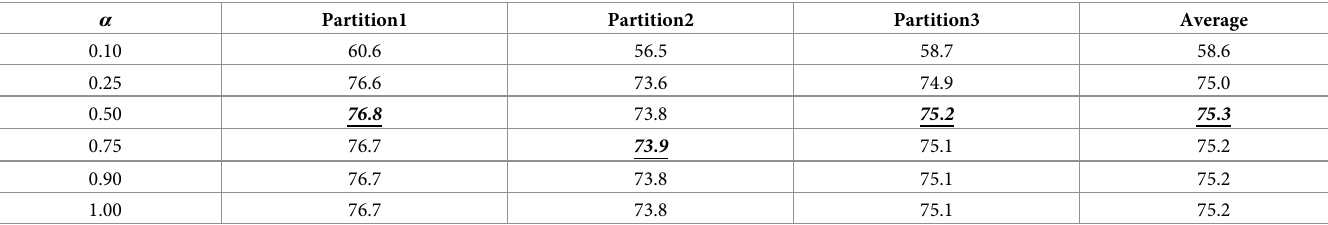
Table 1. The effect of different α and different partitions on hmdb-51 about